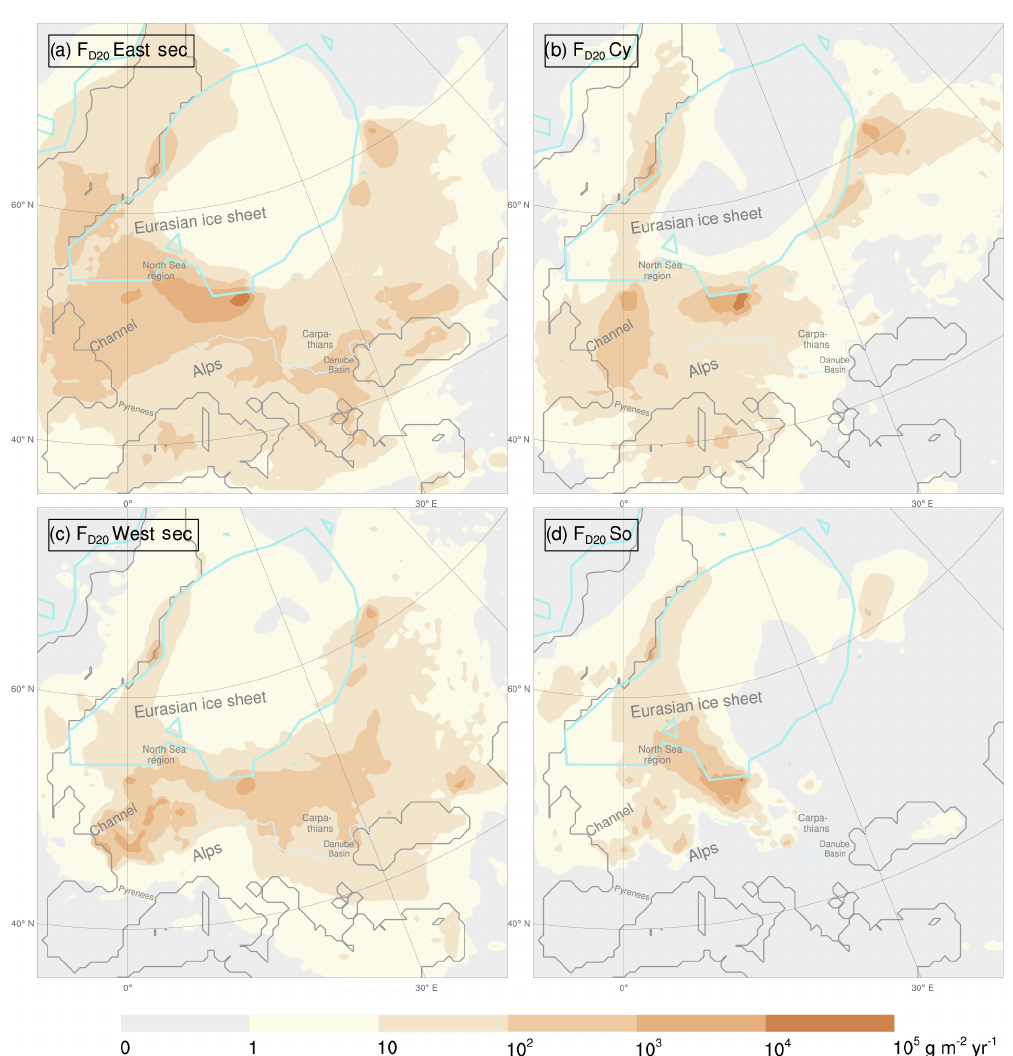
Figure 9. Dust deposition rate fractions caused solely by the (a) northeasters, easterlies, and southeasters; (b) cyclonic regimes; (c) south- westers, westerlies, and northwesters; and (d) the southerlies during the Last Glacial Maximum. The simulated deposition rates are weighted according to the occurrence frequency of the associated wind regime(s) in the Max Planck Institute Earth System Model (Table 2). Dust particles up to 20µm in diameter have been considered. The ice sheet extents (turquoise; Cline et al., 1984), the Danube (light blue), and the coastlines (grey; Braconnot et al., 2012) are